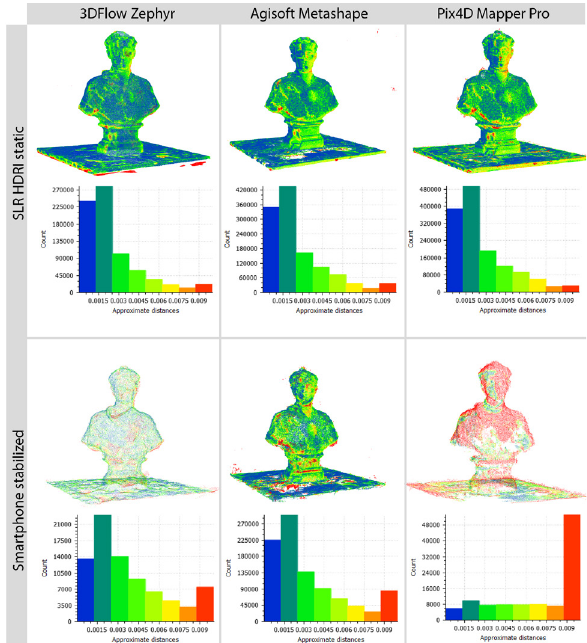
Figure 15. Comparison of the meshes obtained by two most favourable survey technics (SLR HDR and stabilized